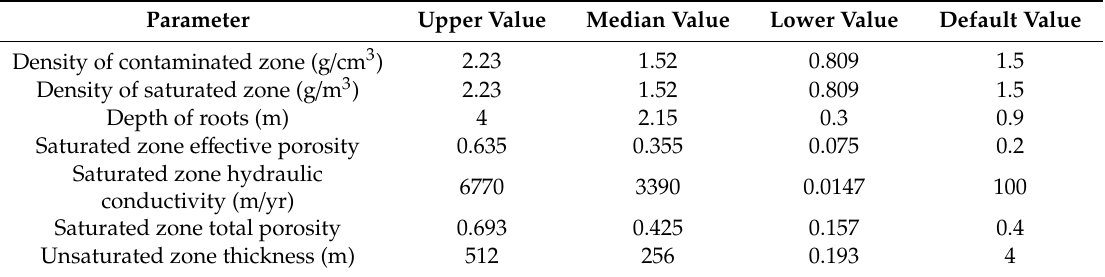
Table 4. Input values for deterministic